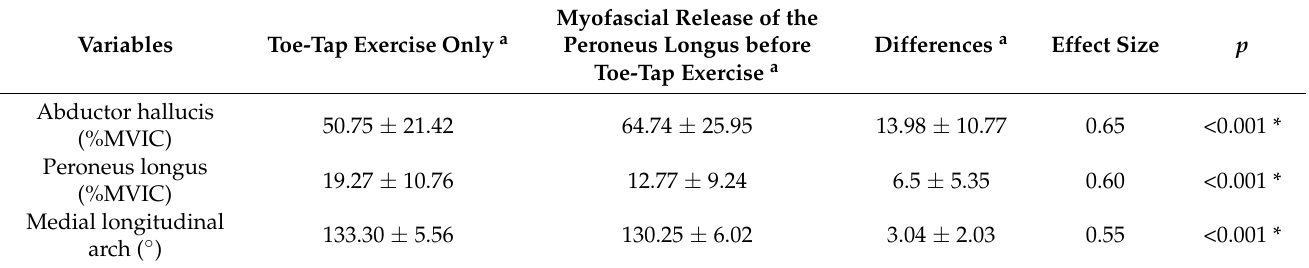
Table 2. Comparison of the muscle activity and medial longitudinal arch angles between the toe-tap exercise alone and the myofascial release of the peroneus longus with subsequent toe-tap